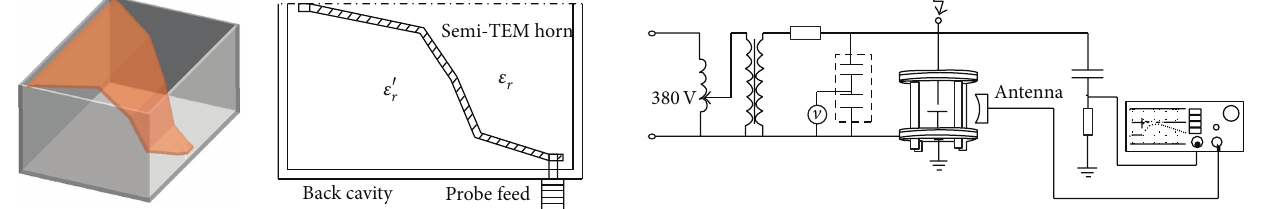
Figure 8: Structure of the quasi-TEM horn antenna.